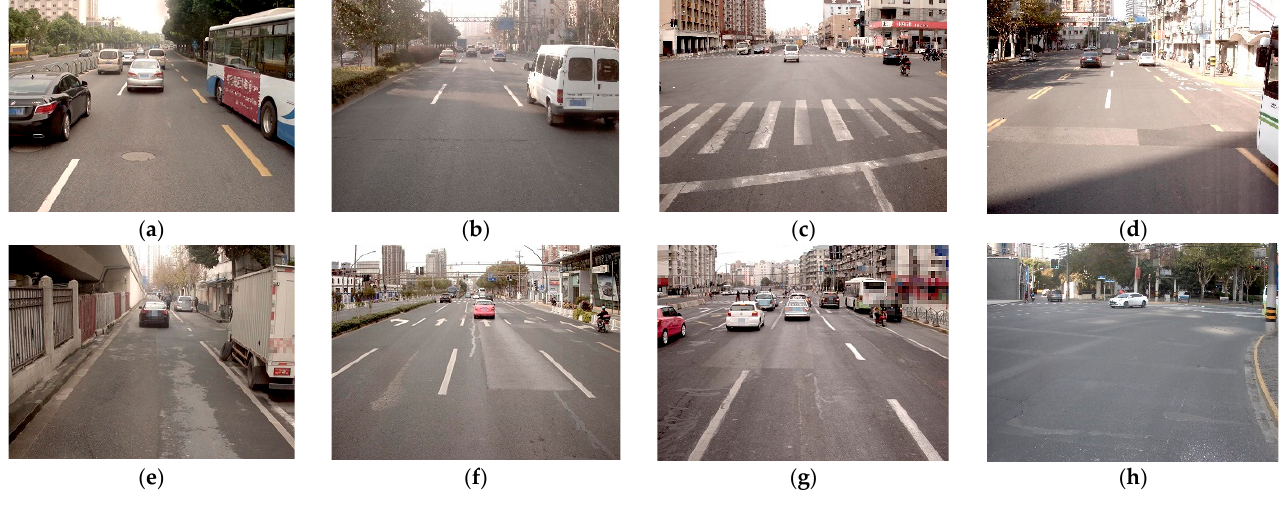
Figure 8. Some examples from the datasets. ( a ) Manhole. ( b ) Crack. ( c ) Other. ( d ) Patch-Pothole. ( e ) Net. ( f ) Patch-Crack. ( g ) Patch-Net. ( h ) Pothole.